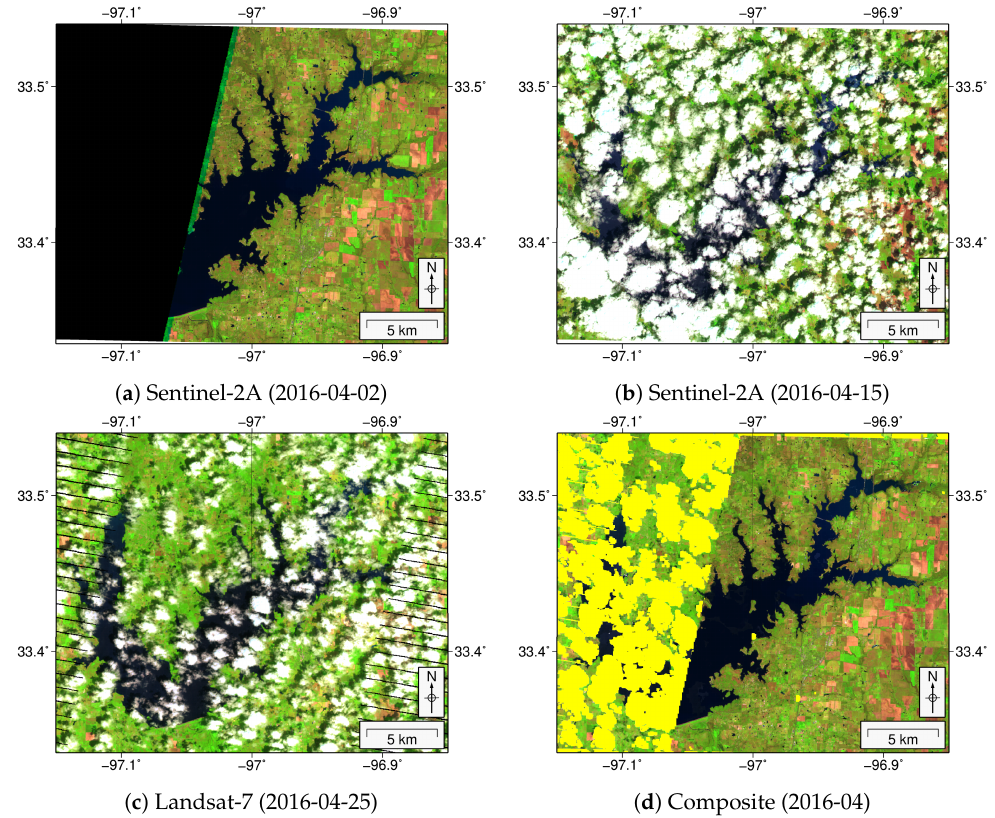
Figure 4. Used daily scenes from Landsat and Sentinel-2 and resulting composite image for Lake Ray Roberts in April 2016. Data gaps in the composite image are highlighted in